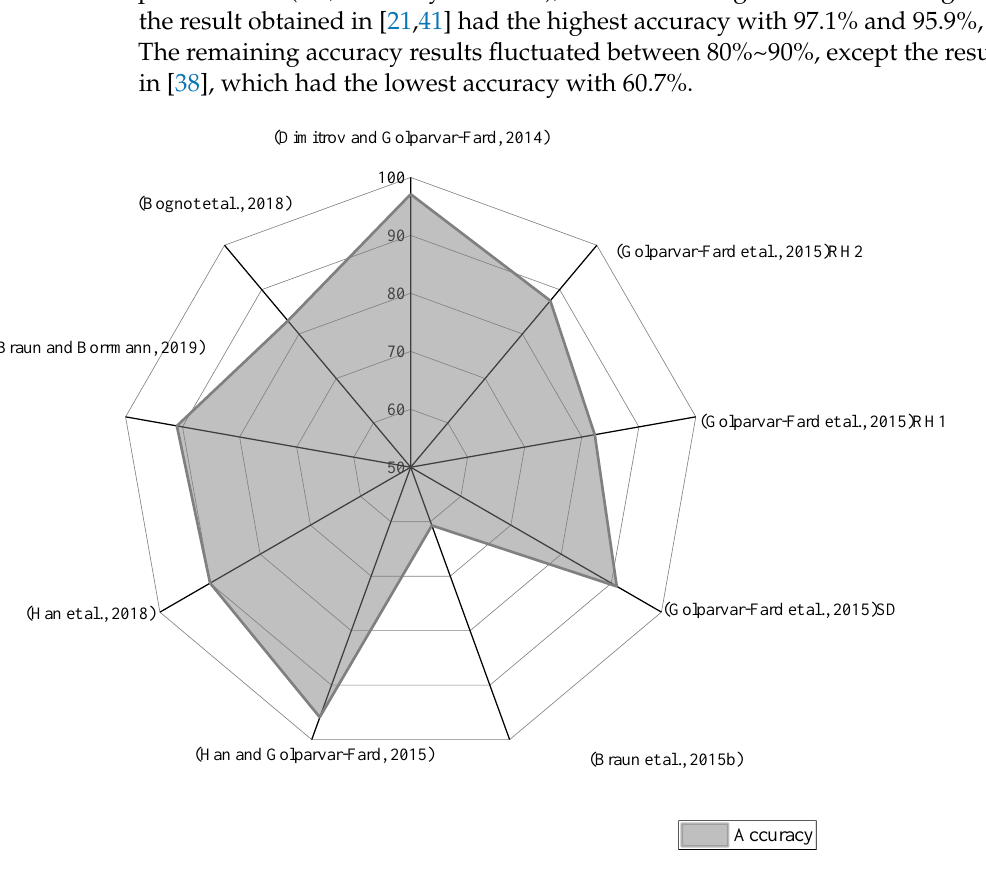
Figure 3. Accuracy (%) of studies [21,37,38,41,47,50,51]of image-processing in CPM.